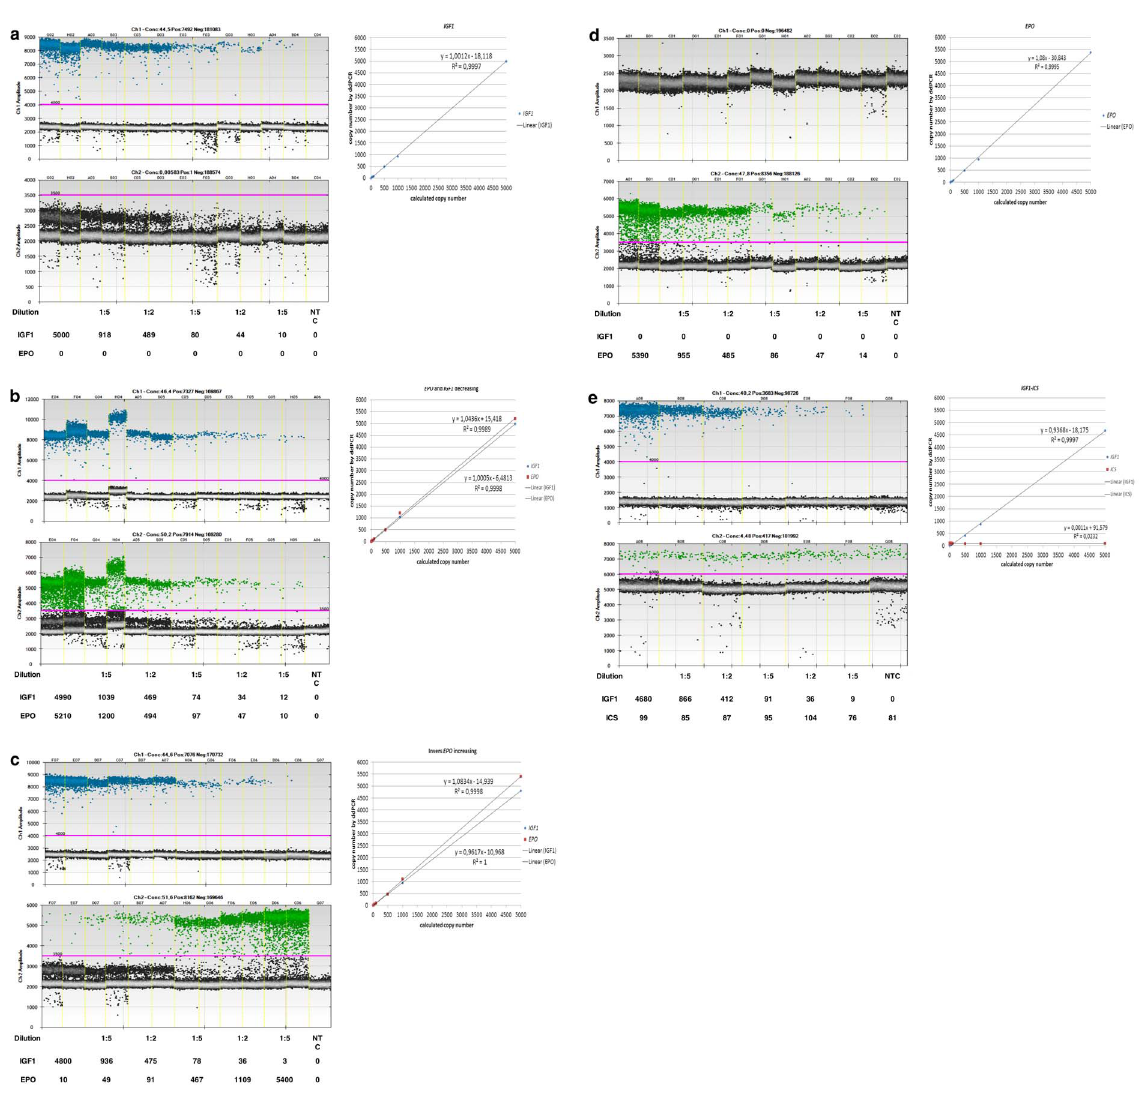
Figure 2. Duplex ddPCR for IGF1 and EPO transgene elements. 500 ng human gDNA were spiked with serial dilutions (1:5; 1:2; 1:5; 1:2 and 1:5) of IGF1 -standard (A), decreasing amounts of IGF1 and EPO -standard (B), inverse amounts of IGF1 (decreasing) and EPO (increasing) (C), EPO only (D) and IGF1 multiplexed with ICS at , 100 copies/reaction (E). Displayed are amplitudes, copy numbers per 20 m l reaction and linearity of the signals.